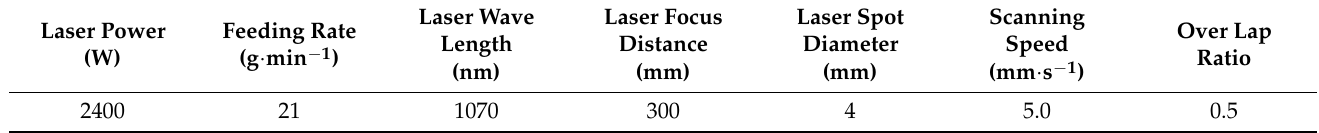
Table 3. The laser cladding parameters.